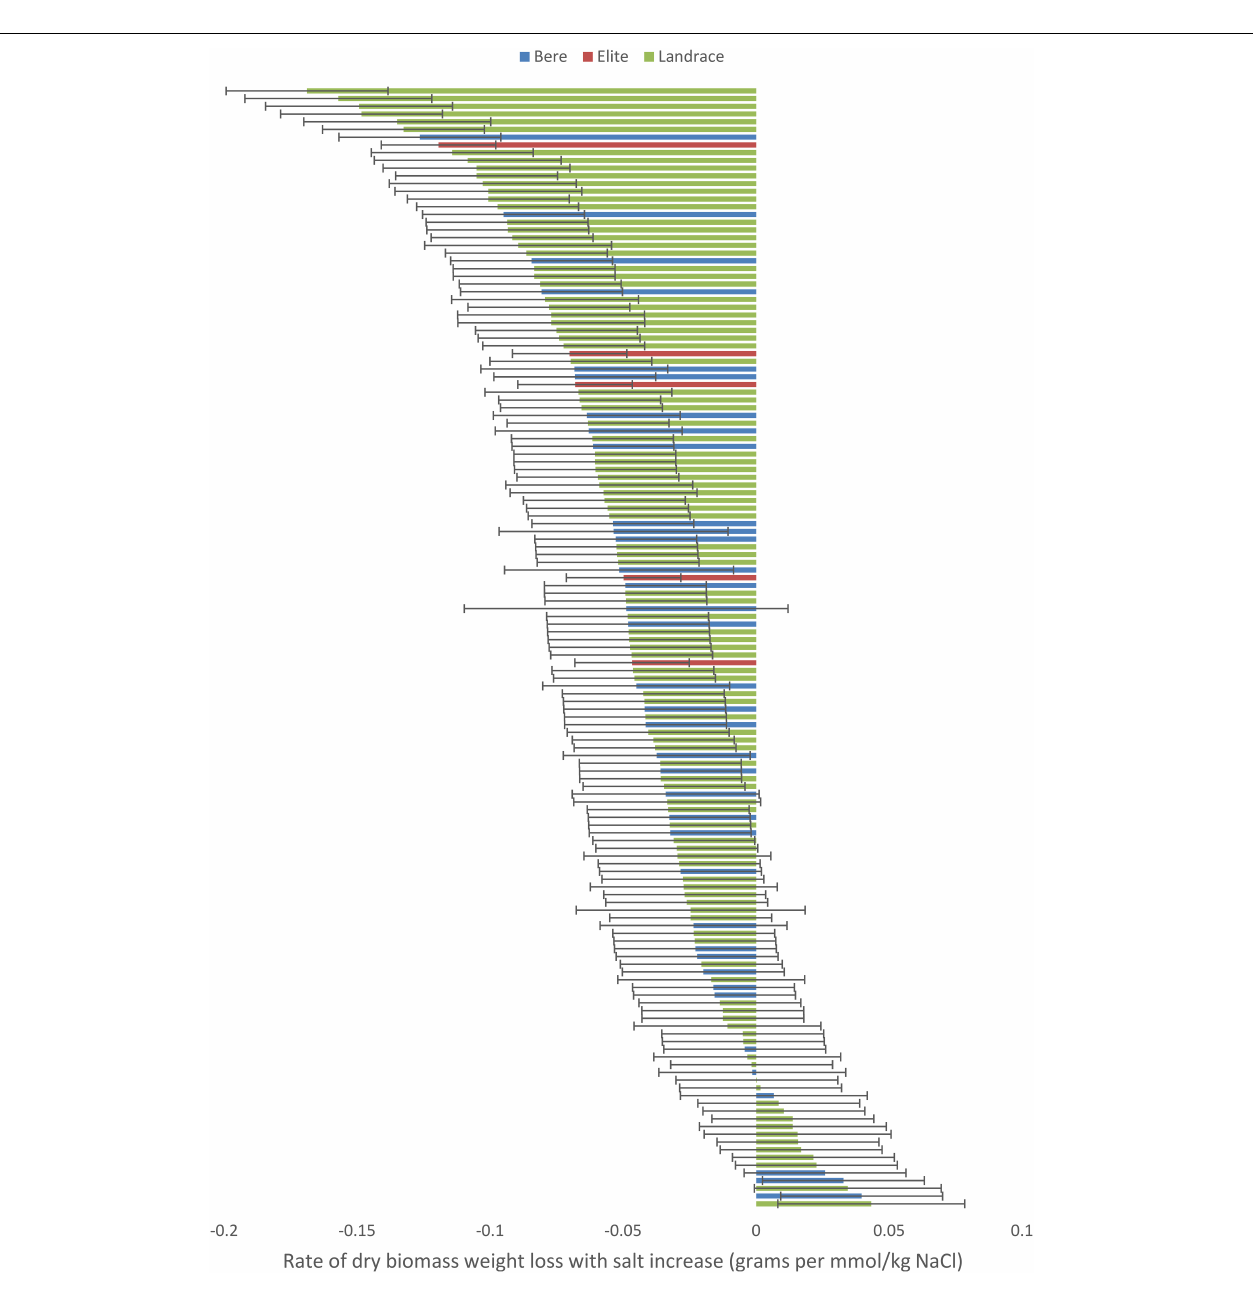
FIGURE 2 | The salinity tolerance measured by the average change in dry weight with increasing salt concentration for 140 lines and 5 elite cultivars of barley grown for approximately 70 days in universal compost. Complete resistance is represented as 0, with negative measurements showing susceptibility, and positive measurements showing salinity preference. Error bars represent the standard errors in positive and negative